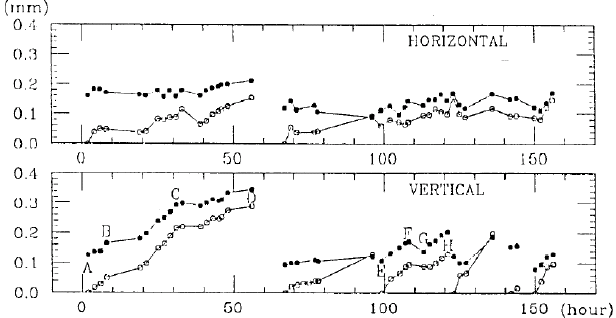
FIG. 5. (Color) KEK-B circumference variations from March 1 to June 30, 2002 [20] (data courtesy of Katsunobu Oide of KEK).